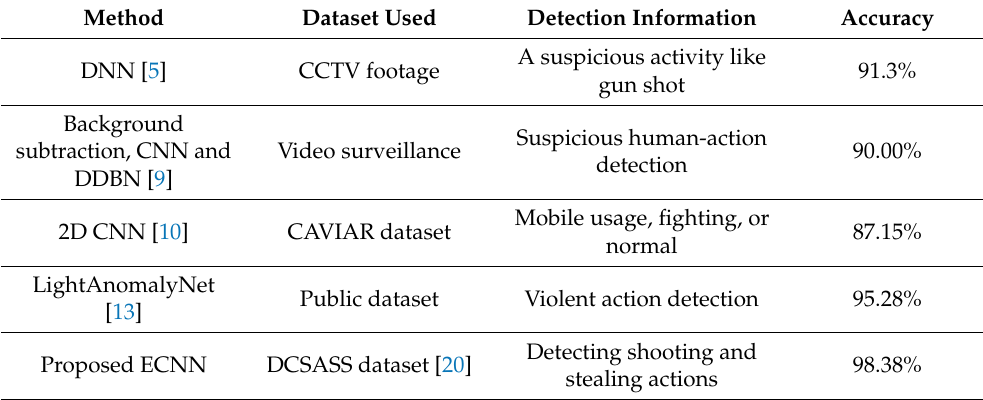
Table 12. Accuracy comparison of proposed ECNN with various existing